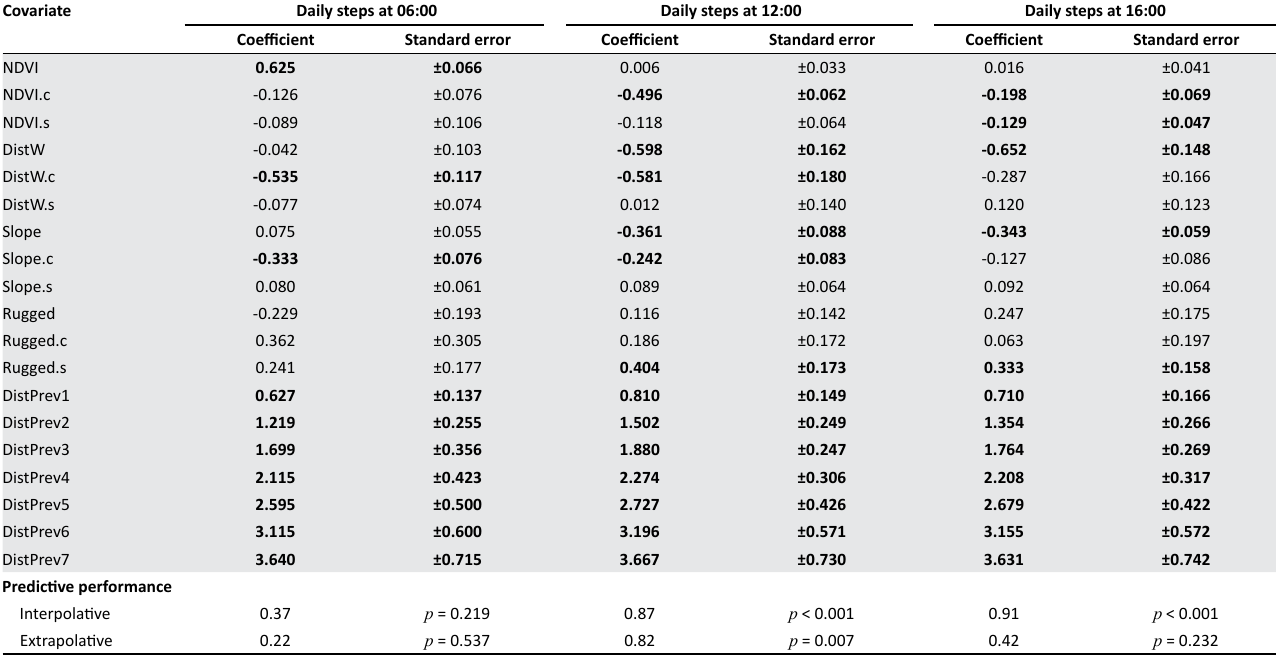
Covariate names follow Table 1. Coefficients interacted with time are indicated by .c or .s, corresponding to their interaction with the cosine or sine time-wave function, respectively. The DistPrev1-7 covariates report the coefficient values from the distance to previous location spline. Standard errors reflect Forester et al. (2009)’s adjustment for serial autocorrelation. Values in bold indicate that the coefficient’s 95 % confidence interval does not overlap zero. Interpolative predictive performance reflects the mean Spearman’s rank correlation using k-fold cross-validation in the Main Camp – Colchester area. P -values for each fold were combined using Fisher’s method. Extrapolative ability reflects the Spearman rank correlation between use by the Nyathi elephant and predictions from the Main Camp – Colchester model. See text for